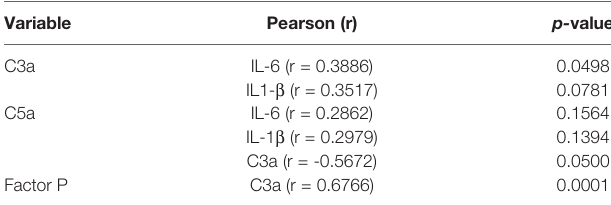
TABLE 2 | Correlation between serum complement proteins and in fl ammatory. cytokines/chemokines.